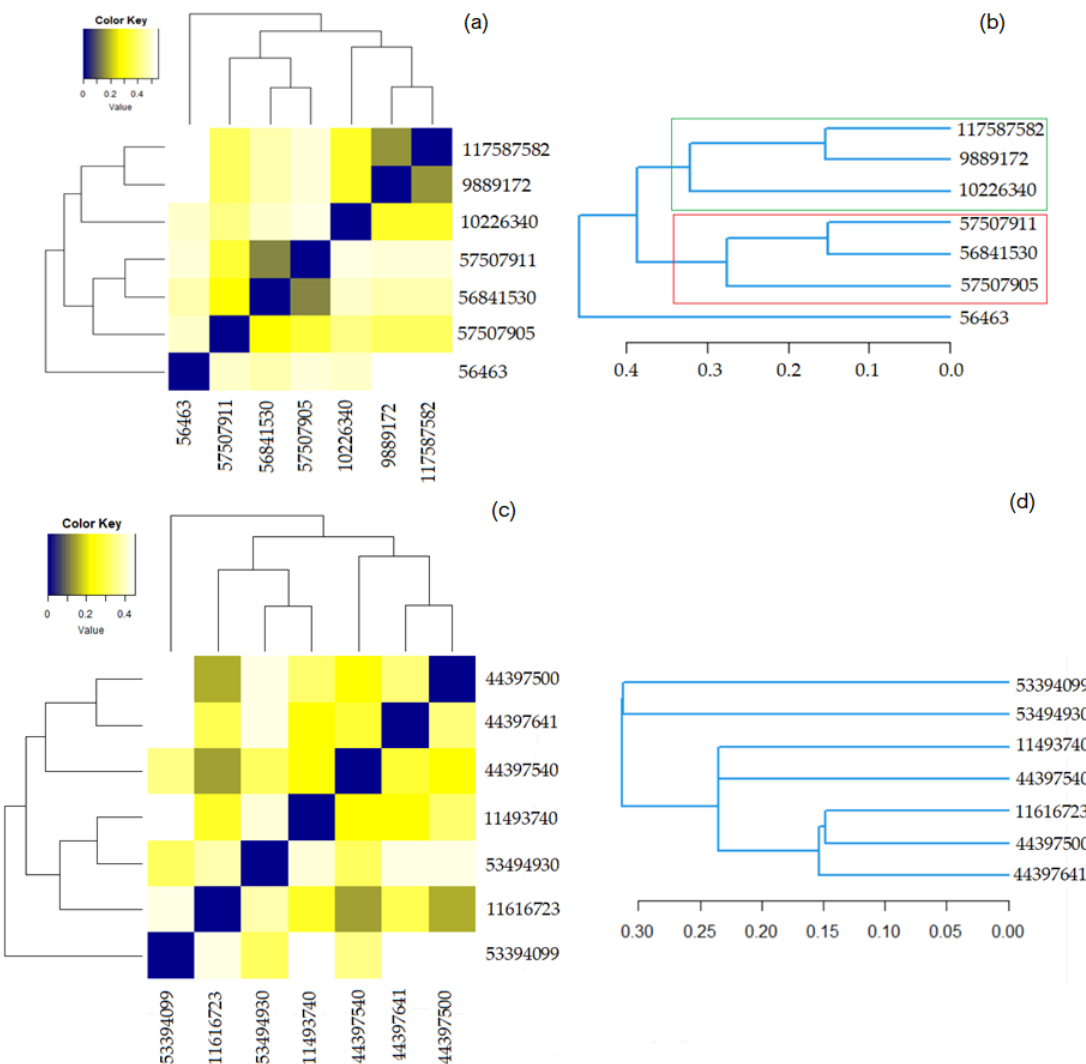
Figure 5. ( a ) The heatmap for Benzoylindoles; ( b ) The dendrogram for Benzoylindoles; ( c ) The heatmap for Phenylacetylindoles; ( d ) The dendrogram for Phenylacetylindoles. heatmap for Phenylacetylindoles; ( d ) The dendrogram for